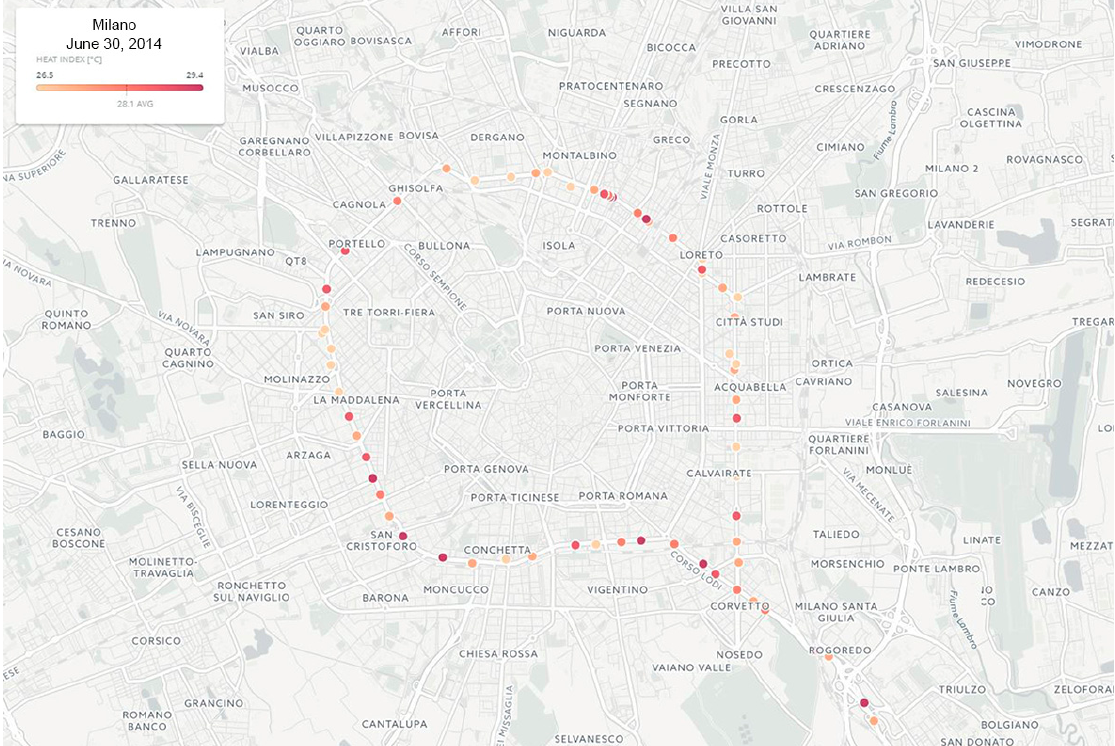
Figure 3. HI profile over Milan on 30 June